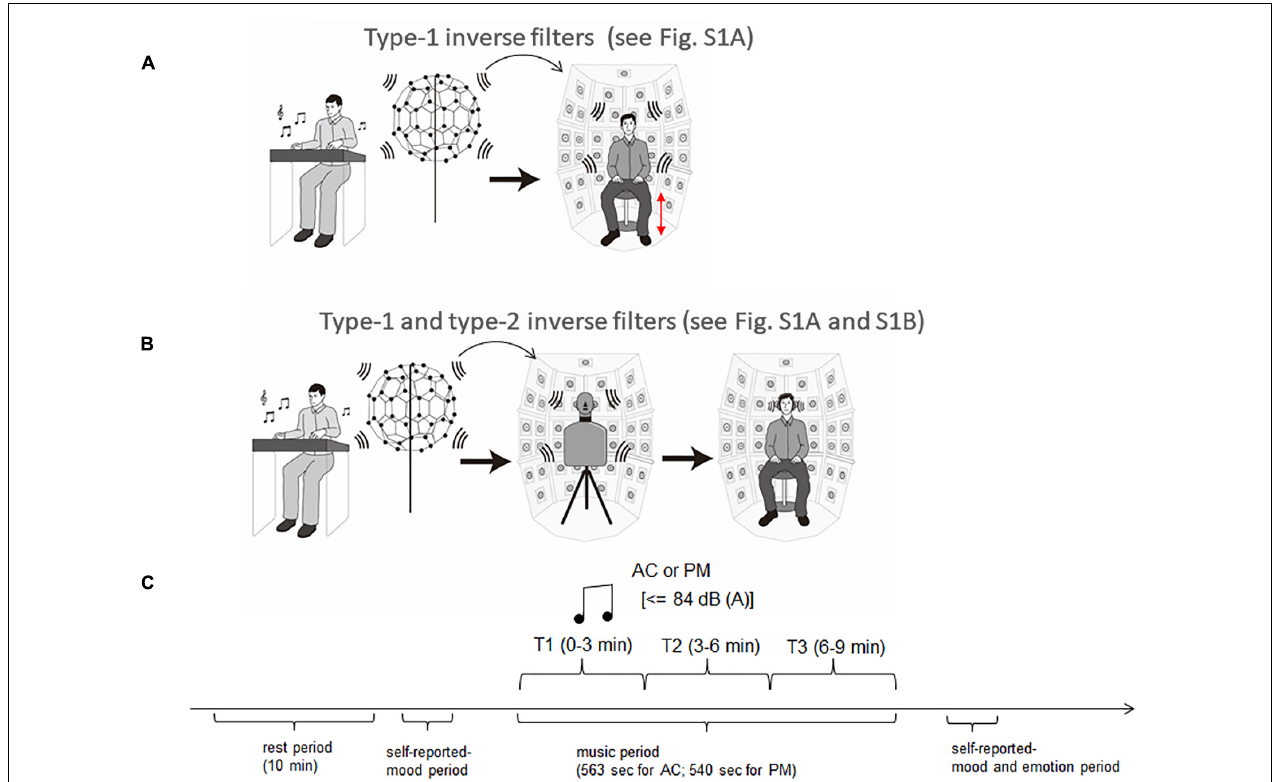
FIGURE 3 | Experimental setup and procedure. (A) Music presentation in the three-dimensional sound field (3D-SF) condition. Music was recorded with the fullerene-like microphone array with 80 channels, and was reproduced in the BoSC reproduction room with 96 channels. To reproduce the accurate sound field in the listening area, type 1 inverse filters were convolved with recorded music signals. The height of the chair was adjusted for each participant so that his/her head position was completely enclosed within the fullerene-like microphone array, which was used for the preparation of type 1 inverse filters. (B) Music presentation in the HD condition. Music in the 3D-SF condition was recorded in the Sound Cask through a dummy head and reproduced with headphones. To remove the frequency characteristics of the headphones, type 2 inverse filters were convolved with the music signals used in the 3D-SF condition. (C) Experimental procedure. Participants experienced one 10-min period of silence as a rest period. After that, they reported their mood and entered the session of music listening. When they finished the listening session, they performed a second self-report of mood and assessed the felt emotion of the music they had listened